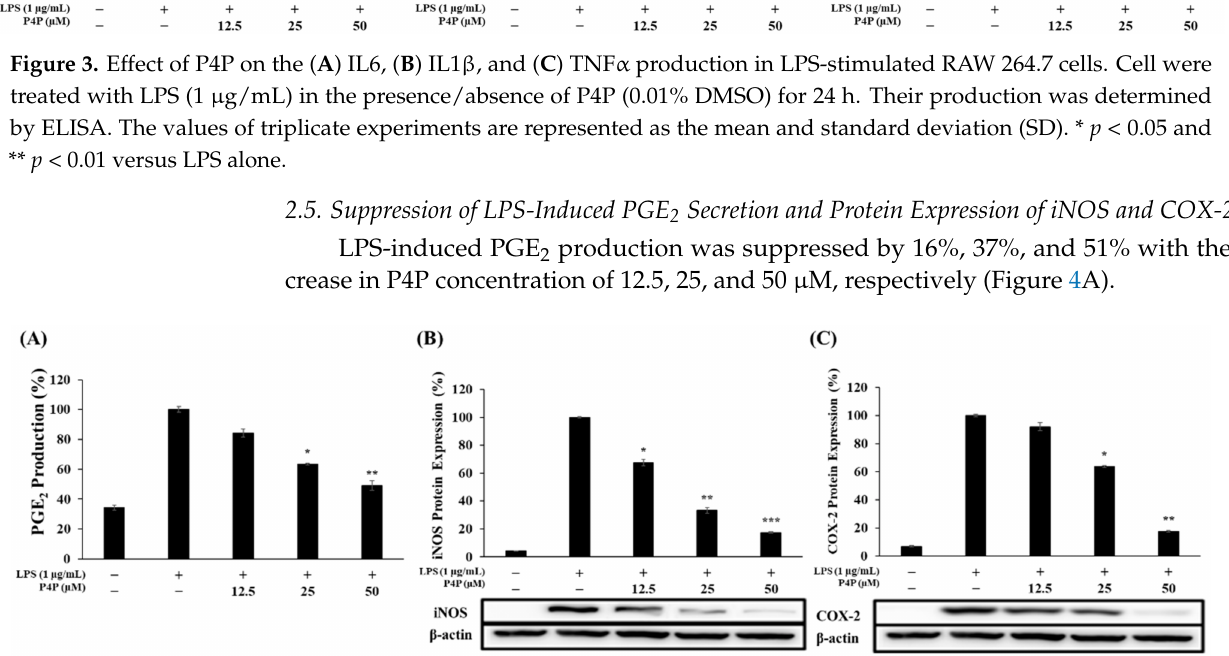
Figure 4. Inhibitory effects of P4P on LPS-induced PGE 2 production and the protein levels of iNOS and COX-2 in RAW 264.7 cells. ( A ) Cell culture supernatant (100 µ L) of cells stimulated with LPS (1 µ g/mL) in the presence (12.5, 25, and 50 µ M) or absence of P4P (0.01% DMSO) was used to determine the level of PGE 2 production by ELISA. Absorbance was measured at 450 nm. ( B , C ) The protein levels of iNOS and COX-2 were determined by Western blot. * p < 0.05, ** p < 0.01, and *** p < 0.005 versus LPS